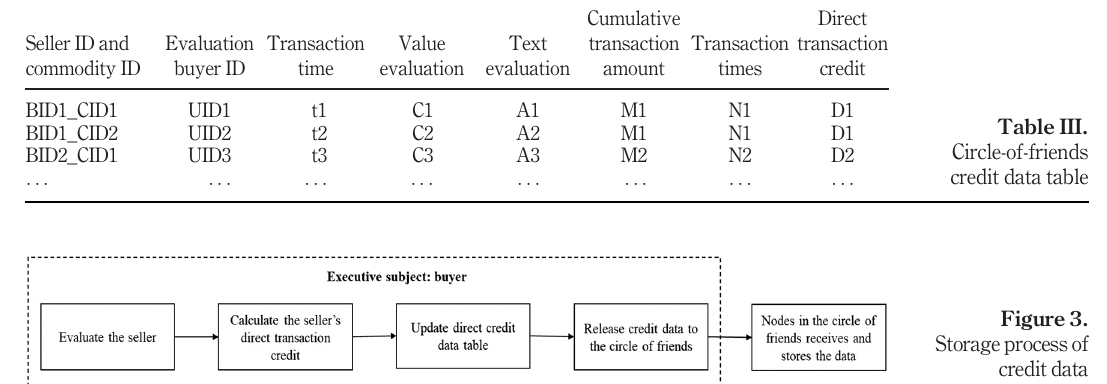
Figure 3. Storage process